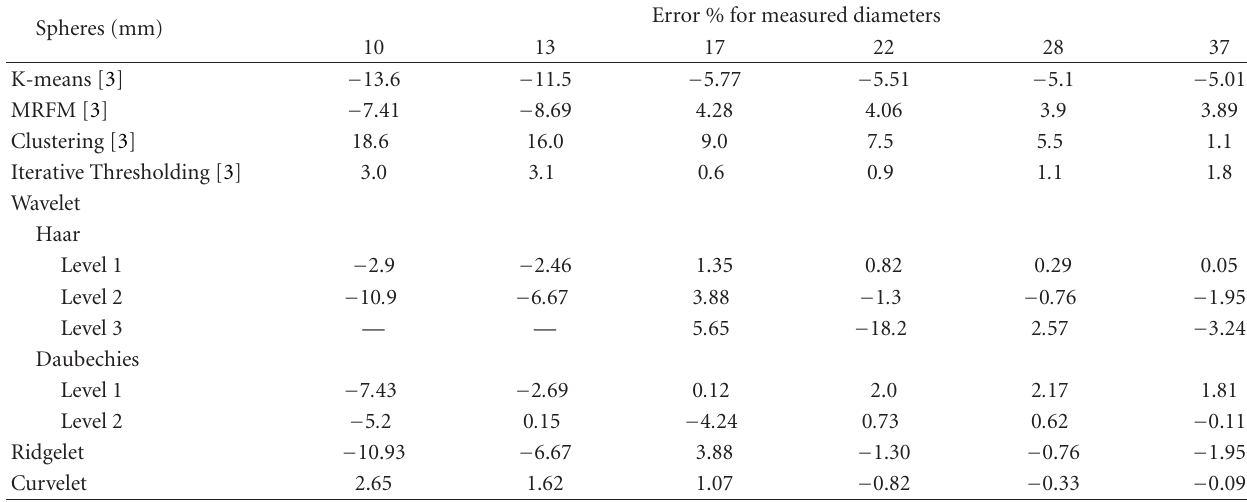
Table 2: The error percentages of spheres diameters measurements for NEMA IEC body phantom.